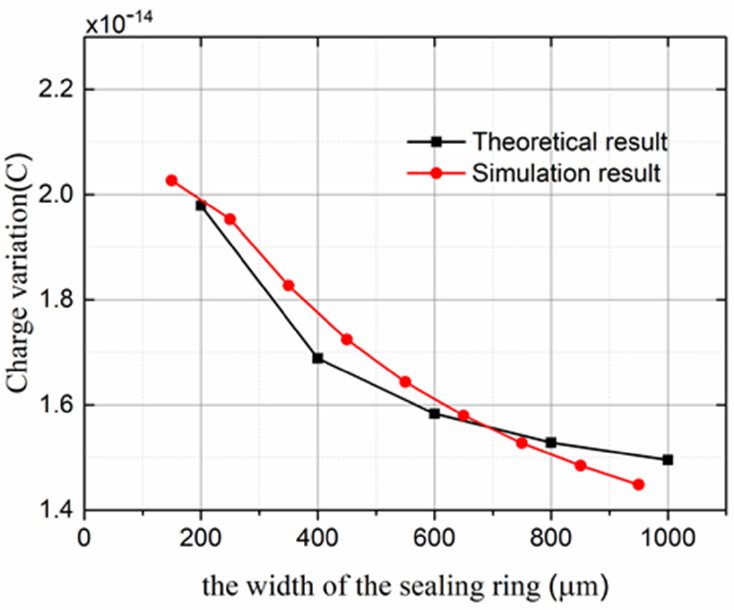
Figure 5. Theoretical-analysis and simulation results of A 2 j versus the width of the sealing ring ( A 3 ), A 2 j is the peak of induced charge variation on the surface of the working electrodes.